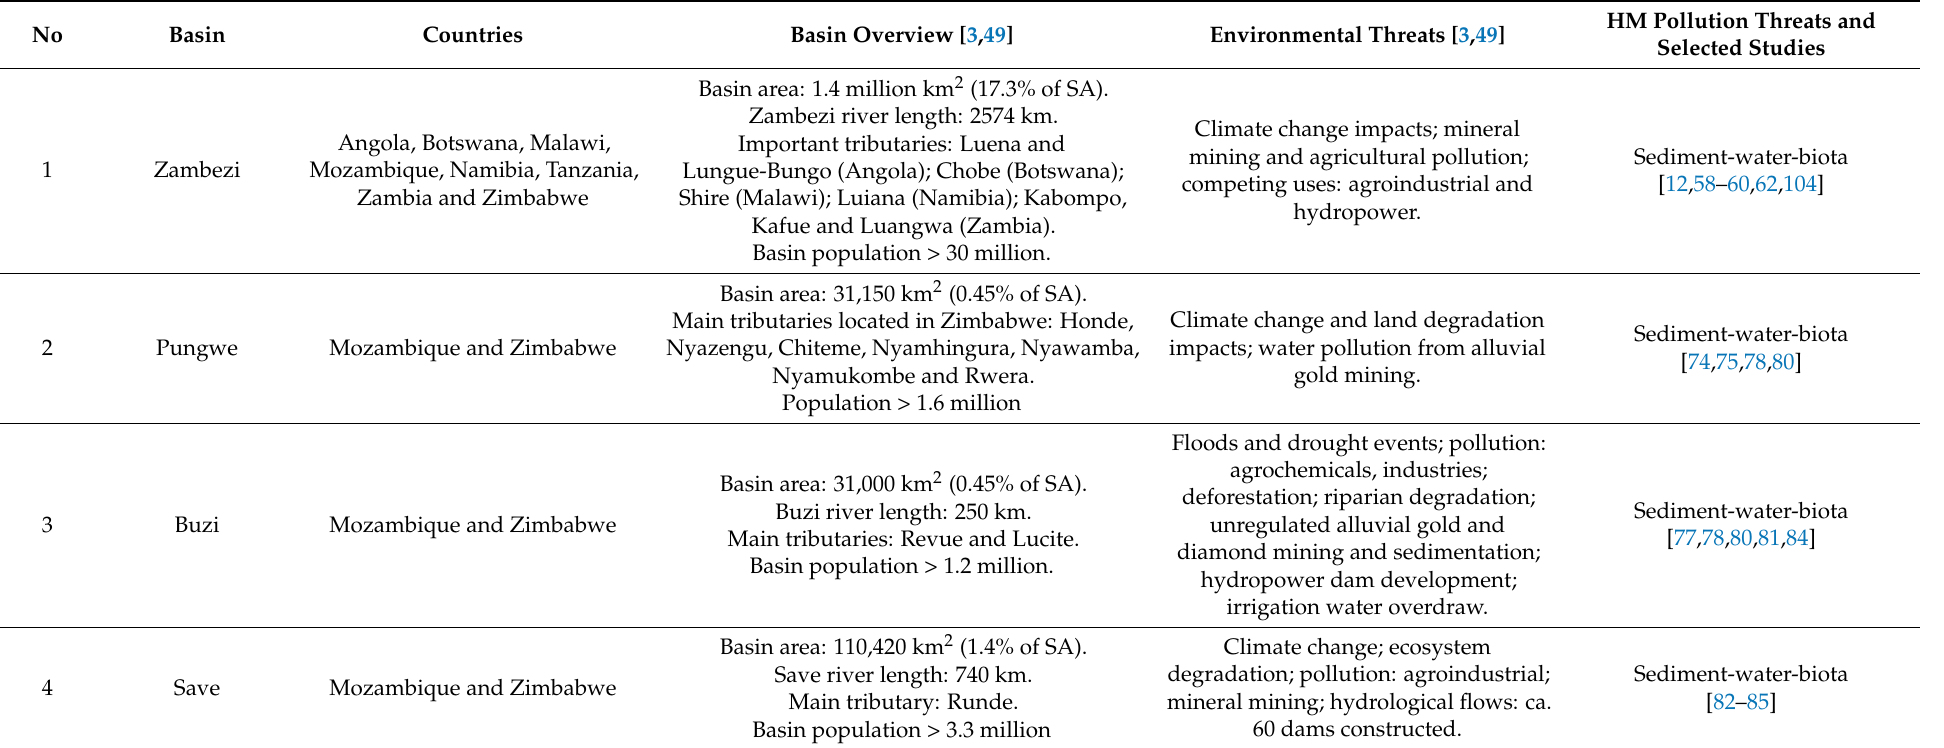
Table 1. Basin characteristics, environmental threats, and selected studies on heavy-metal mining impacts to lotic systems of Southern